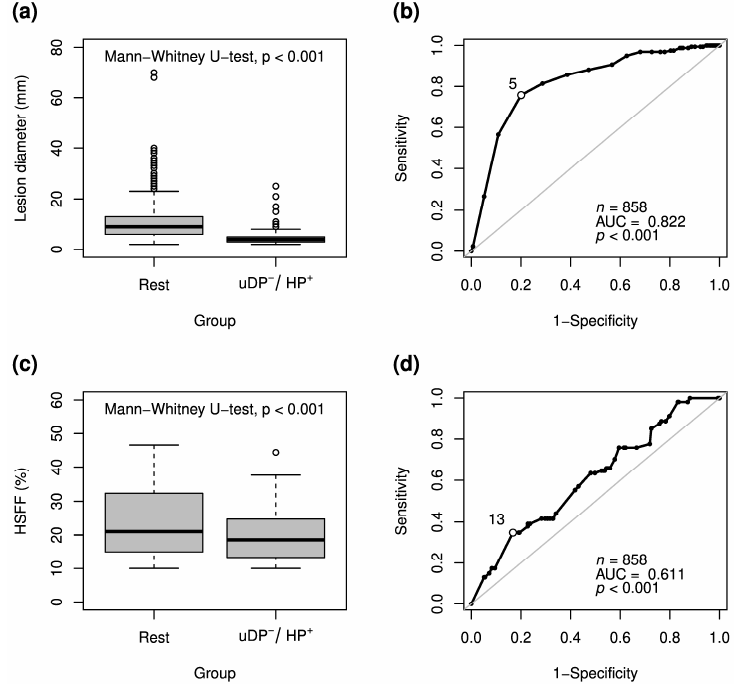
Figure 2. Boxplots ( a , c ) and receiver operating characteristic (ROC) analysis ( b , d ) for metastatic lesions detected exclusively in the hepatobiliary phase images but missed in the unenhanced and dynamic phase images (uDP − /HP + ) in relation to lesion diameter and HSFF for both observers. The circle with white background ( b , d ) indicates the optimal cutoff (based on Youden index). Total serum bilirubin levels ranged from 0.2 to 2.0 mg/dL. No significant differences were observed between lesions visible only in HP images (median (IQR), 0.4 (0.3–1.2) mg/dL vs. 0.4 (0.3–0.7) mg/dL; p = 0.23). The observed median relative gadoxetic acid up- take ranged from 46% to 130%. Metastases observed only in HP images showed no signif- icant differences to other lesions (median (IQR), 89 (78–106)% vs. 91 (77–103)%; p = 0.61). 3.4. Lesions Detected Exclusively in the Unenhanced and Dynamic Phases Metastatic lesions exclusively positive in uDP were similar in size to all other de- tected lesions (median [IQR], 7 (6–9) mm vs. 8 (5–12) mm; p = 0.354) with an AUC of 0.53 ( p = 0.354) in ROC analysis (Figure 3a,b). The case “lesion is positive in uDP and negative in HP” was more likely to occur with a higher HSFF (median (IQR), 45 (45–45)% vs. 19 (15–31)%; p < 0.001; Figure 3c). ROC analysis for lesions detected only in uDP sequences but missed in the HP revealed an AUC of 0.93 with an optimal HSFF cutoff (Youden in- dex) of 42% (sensitivity, 80.2%; specificity, 94.1%; p < 0.001; Figure 3d). The cutoff for HSFF closest to 100% sensitivity with acceptable specificity was 30% (98% sensitivity; 72% spec- ificity).